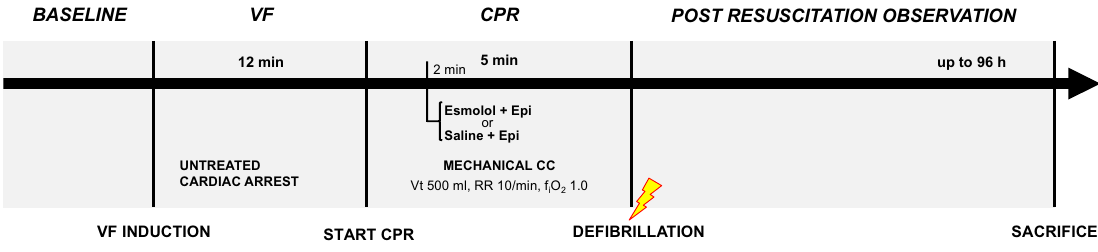
Figure 1. Study design. VF, ventricular fibrillation; CPR, cardiopulmonary resuscitation; CC, chest compression; RR, respiratory rate; Epi,